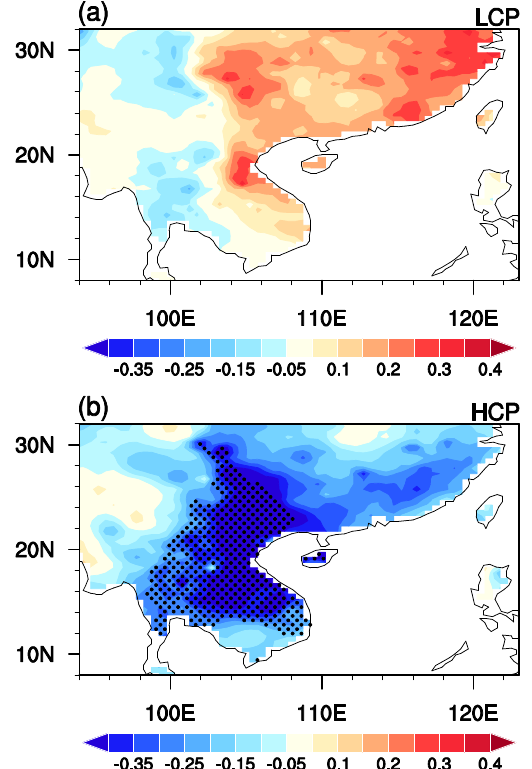
Figure 4. SAT anomalies (°C) during boreal winter regressed upon the standardized winter